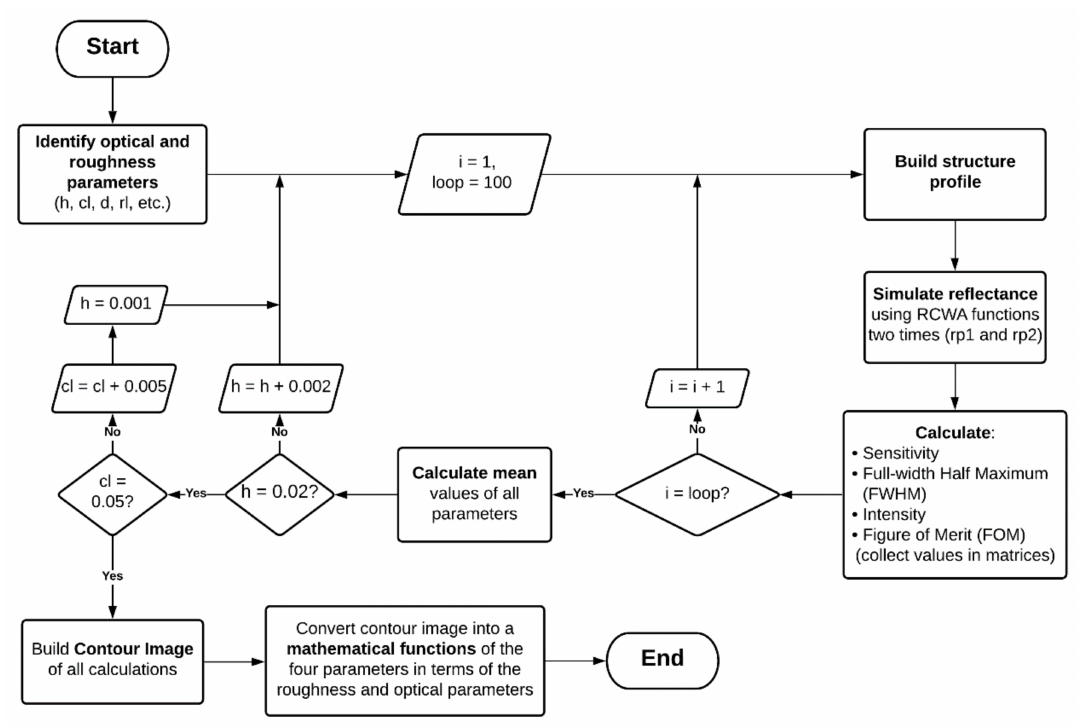
Figure 5. Flowchart of the simulation and calculation processes, including structure profile construction, RCWA, and sensor-quality